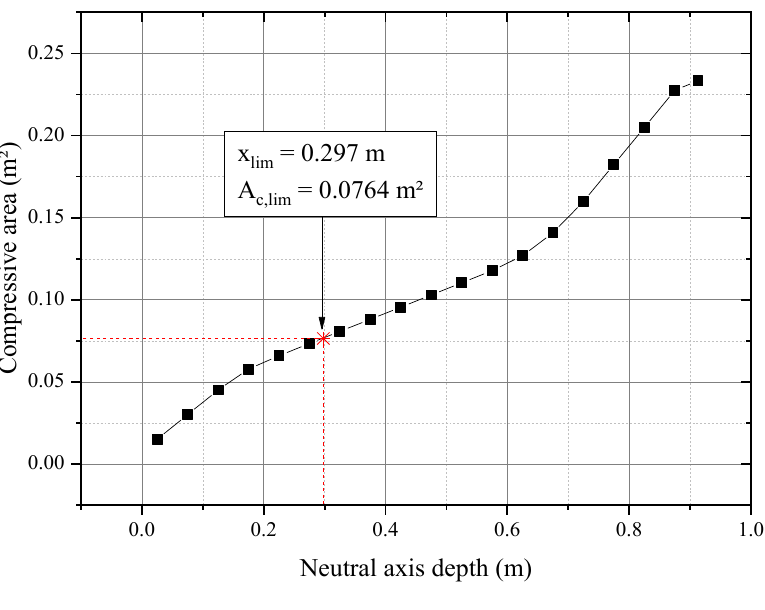
Figure 8. Geometrical law – Compressive area vs. Neutral axis depth (PCI AASHTO type SII)